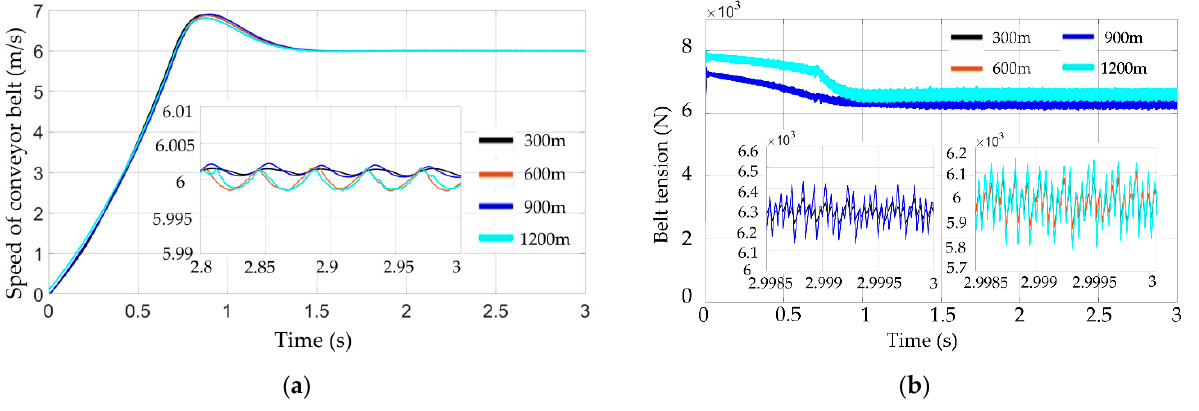
Figure 11. Conveyor belt response curve of distributed permanent magnet direct-drive belt conveyor system under light load operation condition. ( a ) Velocity curve; ( b ) Tension curve.